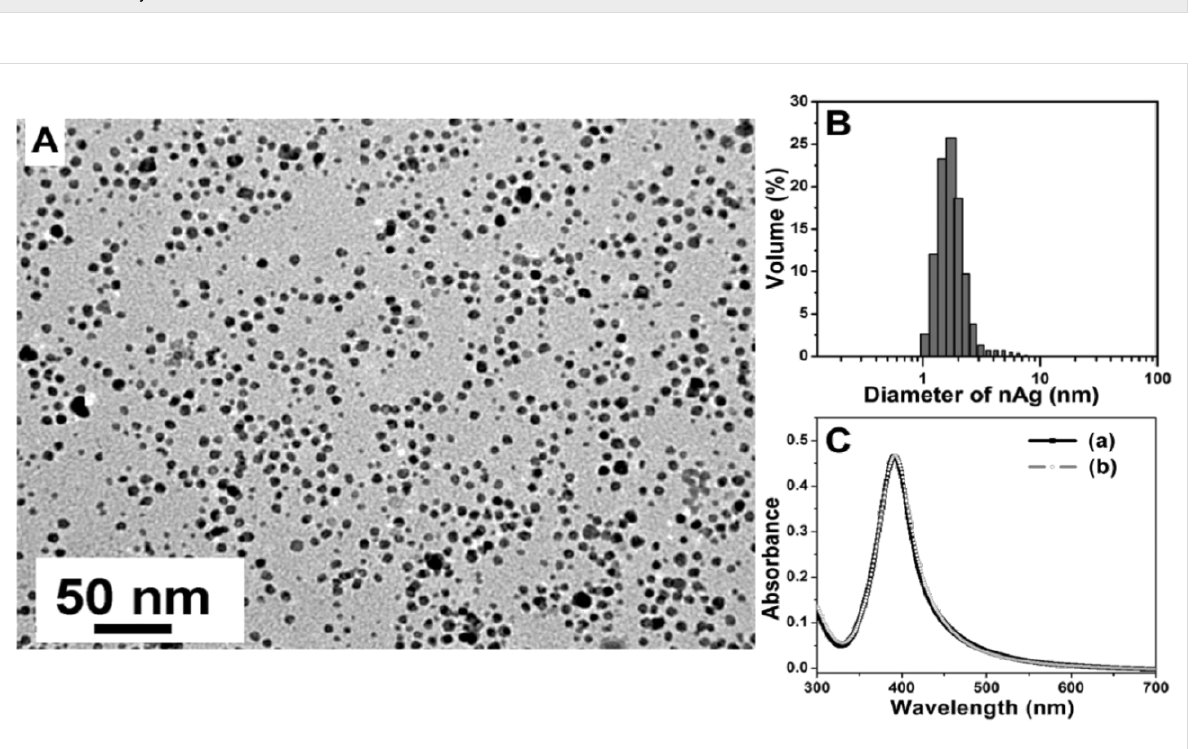
Figure 12: Experiment investigating the stability of AgNPs. (A) TEM micrograph after sample drying. (B) In situ size distribution by dynamic light scat- tering. (C) UV–vis absorption spectra of AgNPs suspended in DI water: (a) freshly synthesized or (b) stored at 4 °C for five months. The peak absor- bance at 390 nm was found to remain unchanged indicating size and shape stability. Reprinted with permission from [55], Copyright 2010 American Chemical